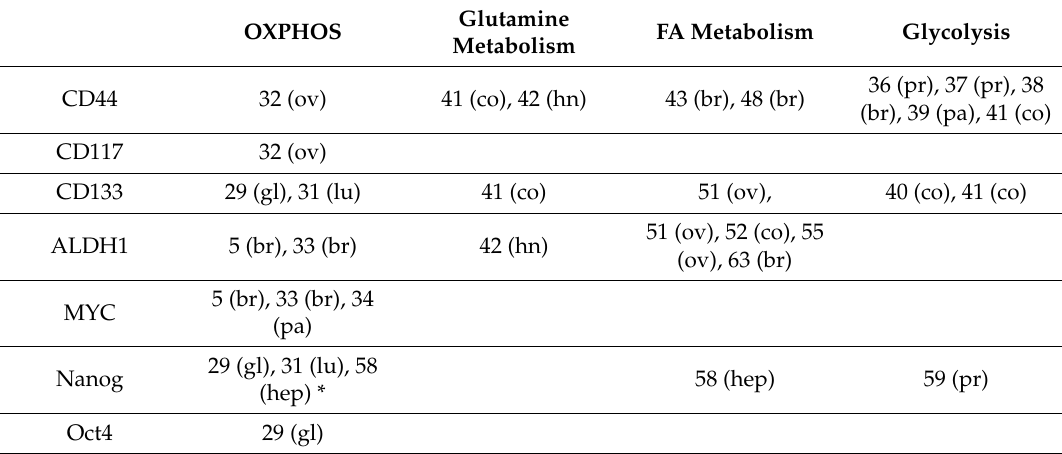
Table 1. Overview of references on tumor-initiating cell (TIC) markers and associated metabolism. Numbers indicate references in the reference list which suggest an association between the indicated TIC marker and a metabolic phenotype. Abbreviations in brackets after each reference indicate the type of cancer in the study. Glutamine OXPHOS FA Metabolism